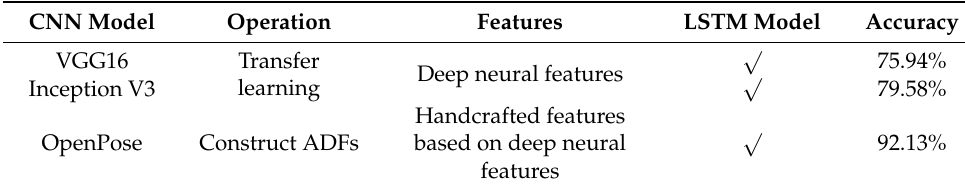
Table 13. Comparison of methods on the custom